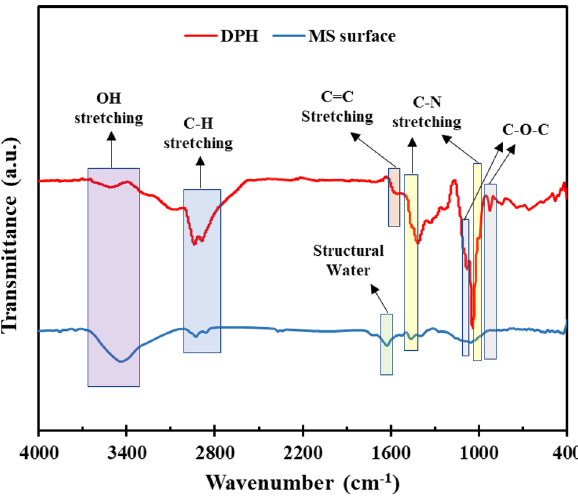
Figure 8. FTIR spectra of MS surface immersed in 1 M HCl solution with 1000 ppm DPH after 4 h.